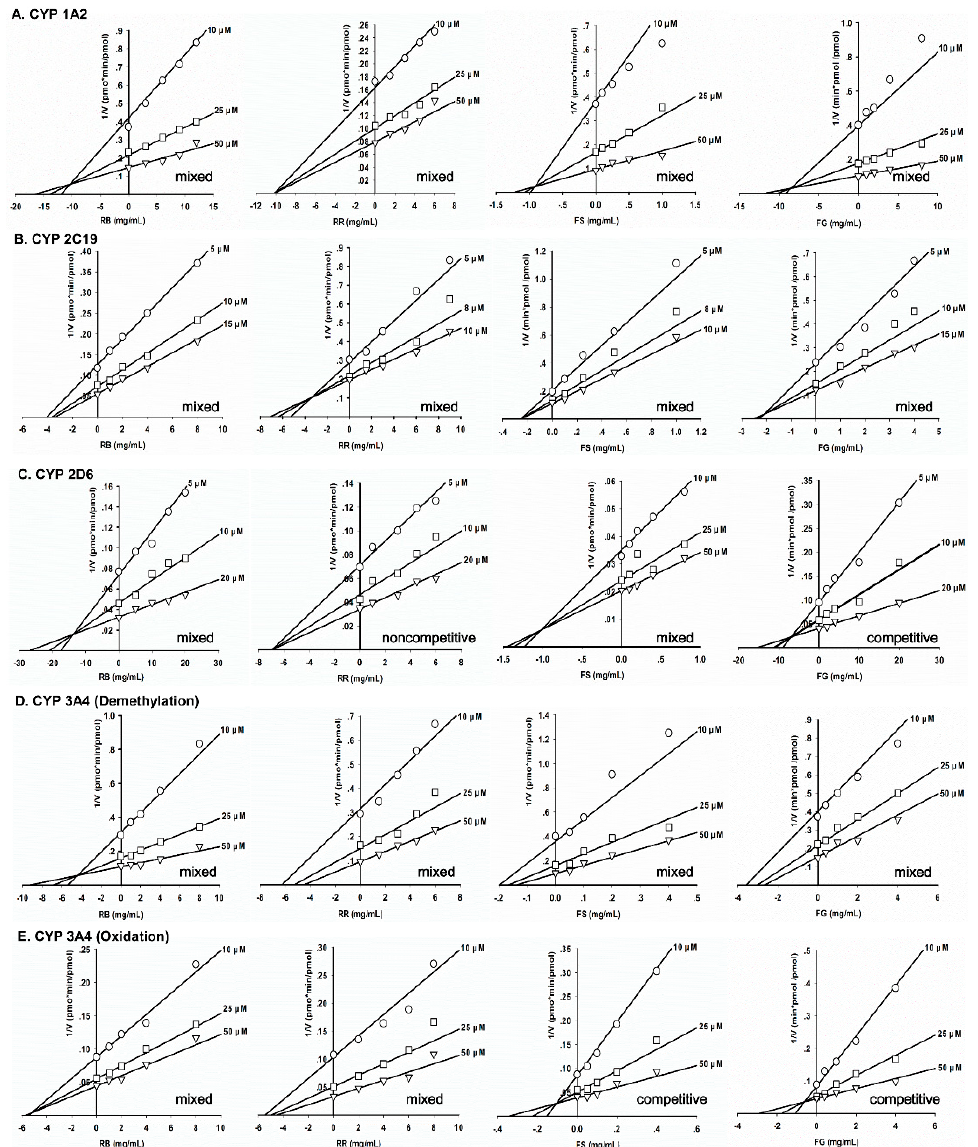
Figure 2. Dixon plot analysis of CLZ demethylation to norCLZ catalyzed by CYP 1A2 ( A ); CYP 2C19 ( B ); CYP 2D6 ( C ); CYP 3A4 ( D ) and CLZ oxidation to CLZ N -oxide by CYP 3A4 ( E ) with various concentrations of Radix Rehmanniae (RR), Fructus Schisandrae (FS), Radix Bupleuri (RB) and Fructus Gardeniae (FG) at fixed CLZ concentrations.